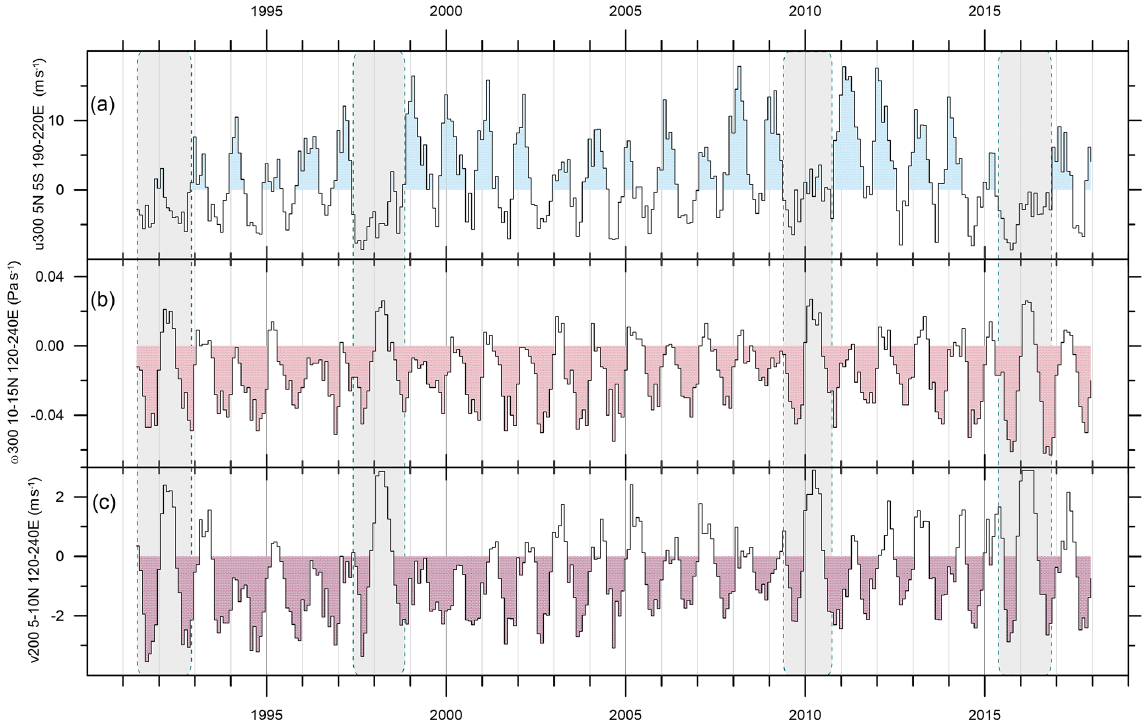
Figure 6. Monthly values of (a) u duct , (b) ω P , and (c) v P . The shading to zero indicates months of enhanced transport which act to reduce the IH (cid:49) CO 2 . Anomalous dynamical periods are highlighted with grey-shaded